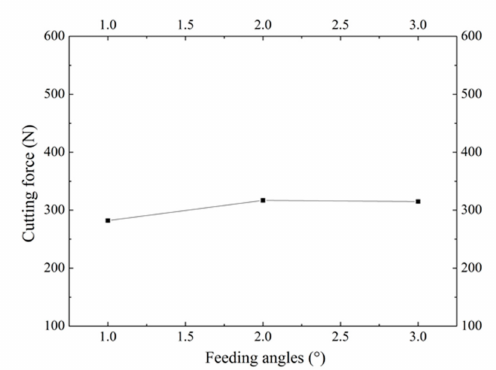
Figure 13. Cutting force under di ff erent feeding angles.